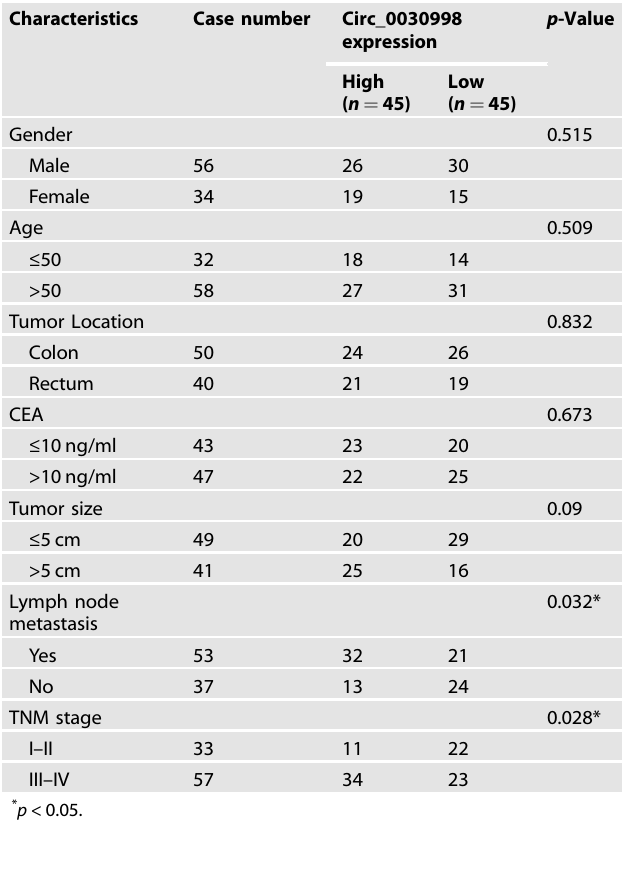
Table 1. Correlation between Circ_0030998 expression and clinicopathologic features of CRC patients. Characteristics